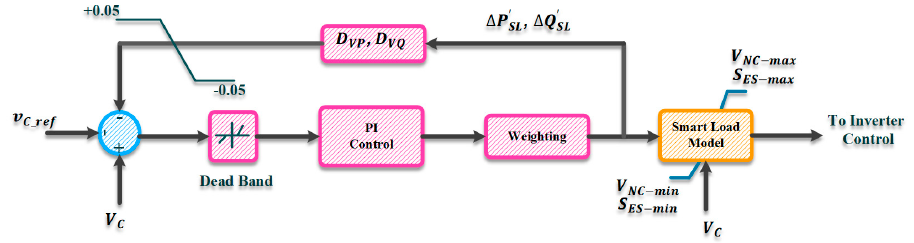
Figure 8. Sample SLBC control loops for voltage control (CVR) purposes